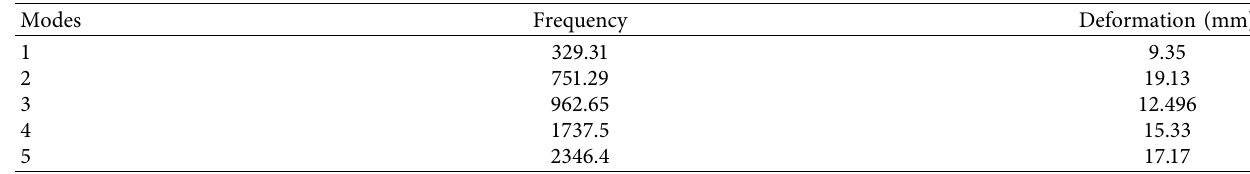
Table 7: Modal analysis results of stainless-steel crankshaft.